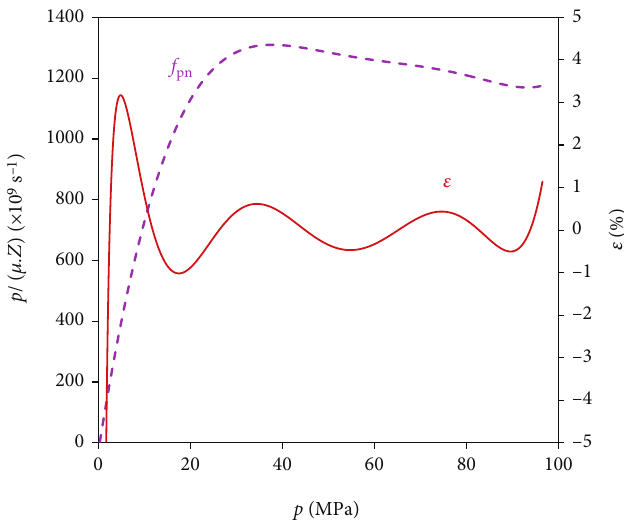
Figure 18: The relation curves of p / ð μ Z Þ and ε vs. p calculated by the polynomial function f